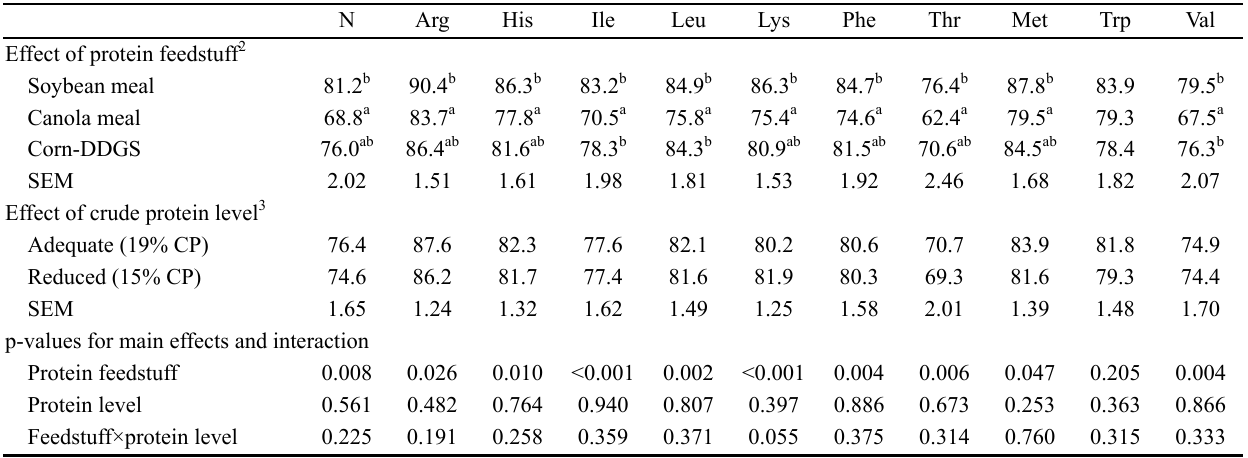
Table 6. Standardized ileal digestibility (%) of nitrogen and indispensable amino acids in growing pigs in response to protein feedstuff used and crude protein level